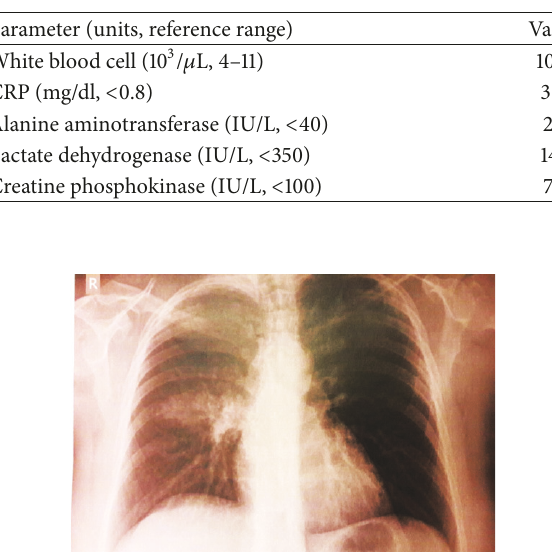
Table 1: Patient’s main laboratory findings on presentation. Notably, leukocytosis is generally uncommon in adults and even in the absence of it, the diagnosis of pertussis should not be excluded.